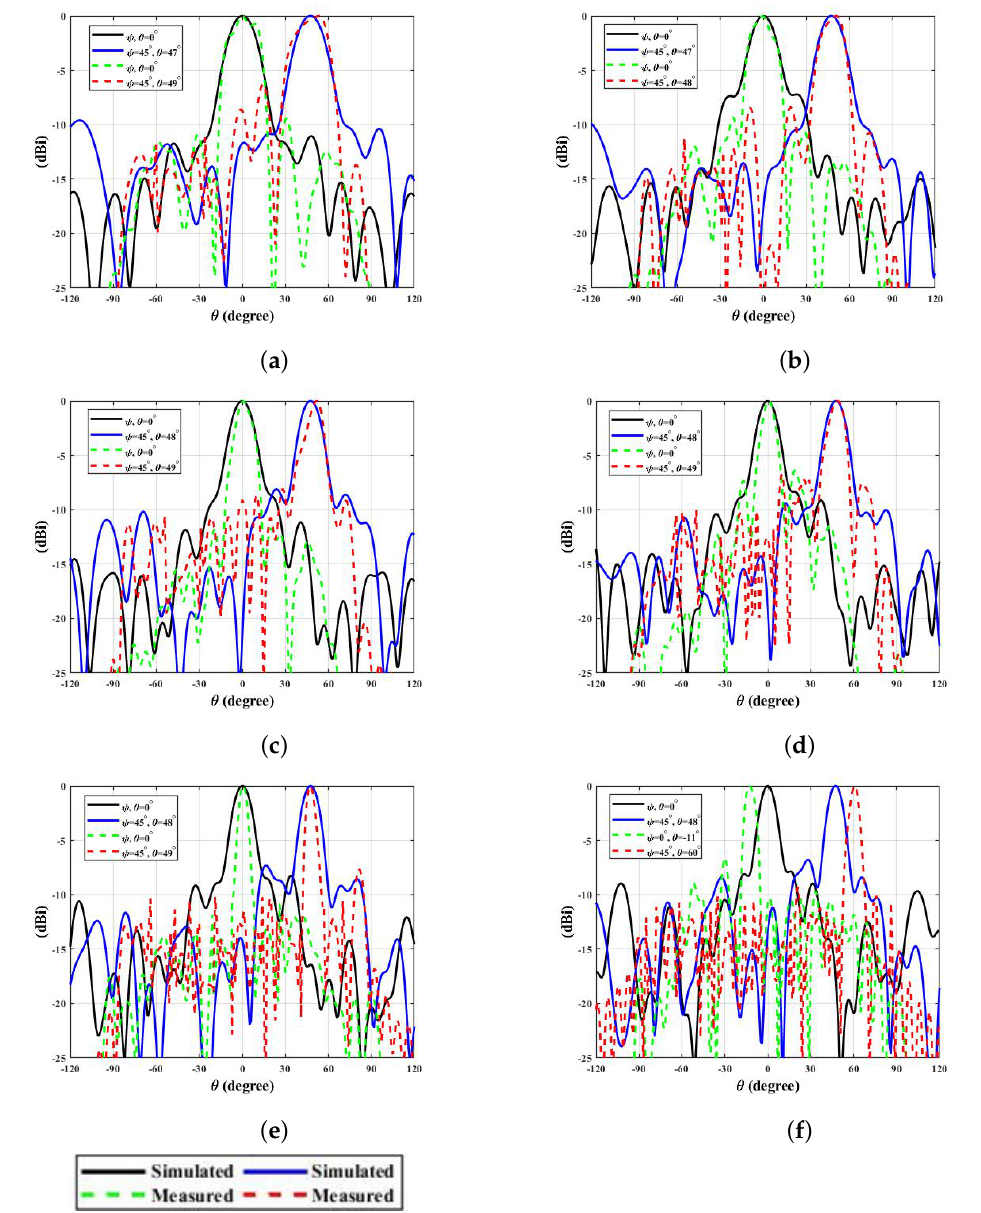
Figure 7. ( a – f ) Simulated and measured steered radiated beam obtained after rotation of feed waveguide in 10 GHz, 11 GHz, 12 GHz, 13 GHz, 14 GHz and 15 GHz